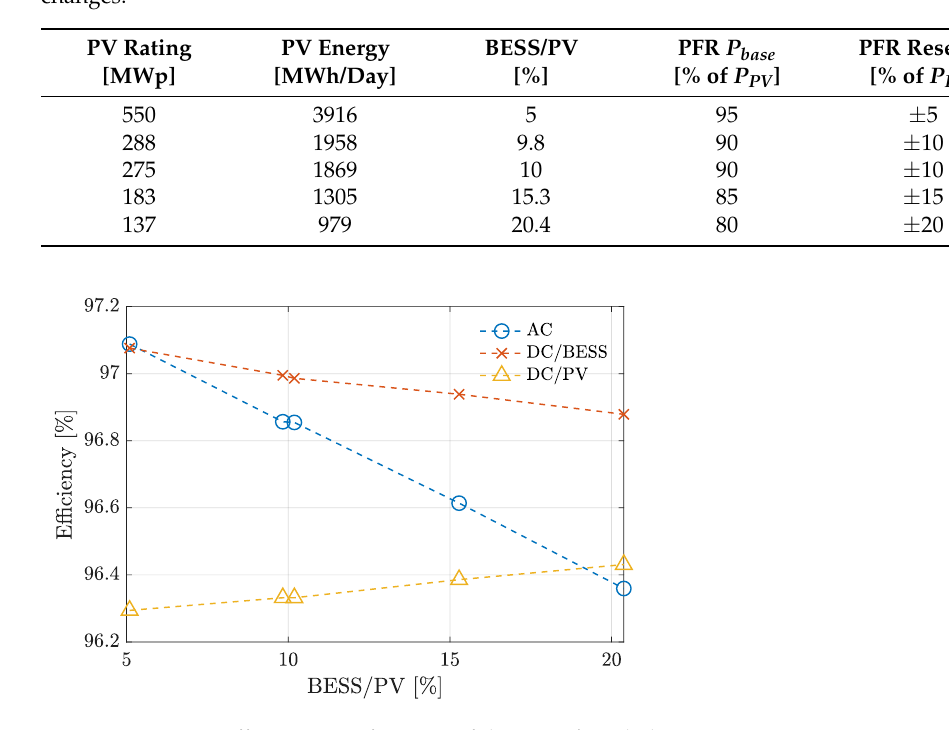
Table 4. The setting of the primary frequency reserve operation for different BESS/PV ratios. In all cases, the same energy capacity (275 MWh of nominal capacity) is considered while the PV rating changes.